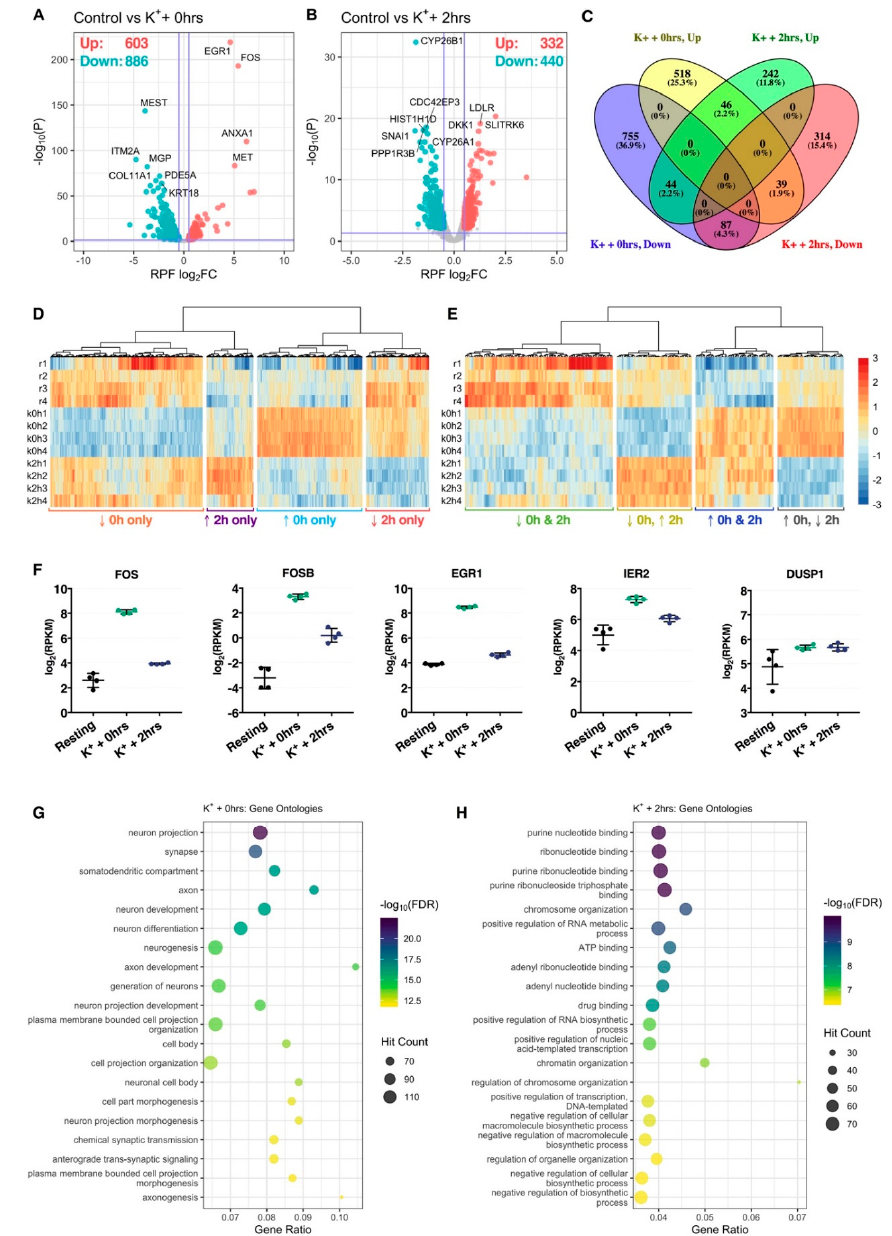
Figure 2. Translational changes induced by membrane depolarization. ( A , B ) Volcano plots comparing translational log 2 fold change (log 2 FC) and –log 10 p -values of genes immediately ( A ) or 2 h ( B ) after depolarization, relative to resting cells. Significantly upregulated and downregulated genes are marked in red and blue, respectively, with Benjamini–Hochberg FDR < 0.05 and log 2 FC > |± 0.5| considered significant. Horizontal line represents nominal p < 0.05. ( C ) Venn diagram depicting the overlap of significant genes between both time-points. ( D ) Heat map comparing RPF RPKM across all samples for genes significantly regulated at one time-point only. Each cell corresponds to the RPKM standard deviation relative to the row-wise mean, with red corresponding to high expression, and blue to low expression (scale bar shared with ( E )). ( E ) As in ( D ), except depicting genes significantly regulated at both time-points. ( F ) Expression of known immediate-early genes, FOS, FOSB, EGR1, IER2 and DUSP1, at the RPF level. All five genes were significantly upregulated at both time-points. ( G , H ) Bubble plots showing top 20 significantly enriched gene ontology terms after analysis of genes significantly upregulated immediately ( G ) or 2 h ( H ) after stimulation. Note that “Gene Ratio” refers to the overlap between the query gene set versus the number of genes categorized under the gene ontology